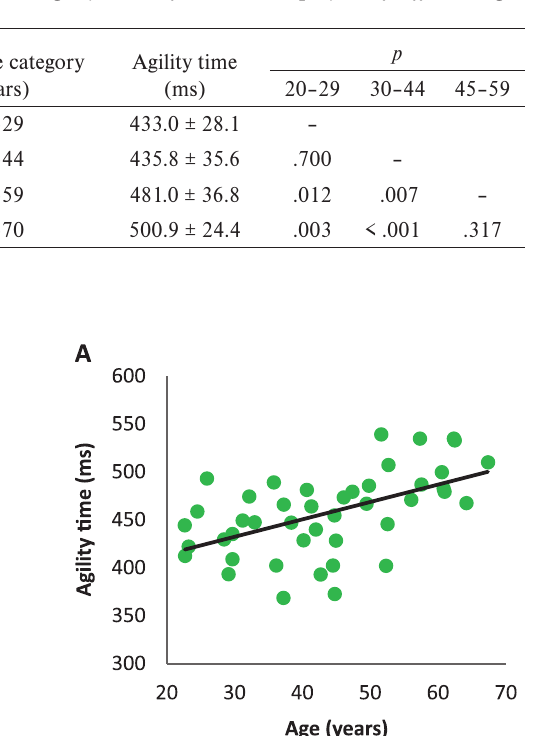
Agility time (mean ± SD) and interdifference matrix between agility times of sedentary subjects of different ages